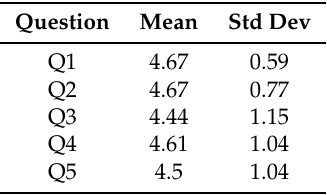
Table 5. The result of usefulness questionnaire of R-WOSARLS in the experiment group. Question